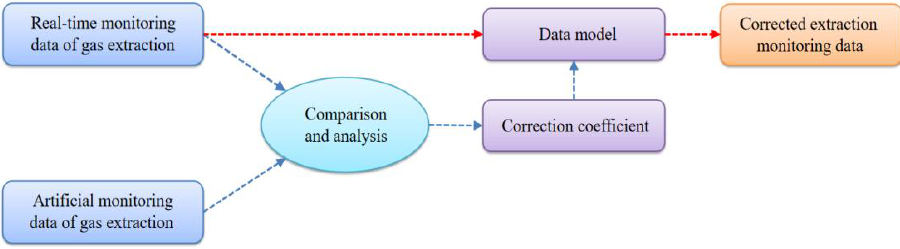
Figure 6. Flow chart of gas-extraction data correction.